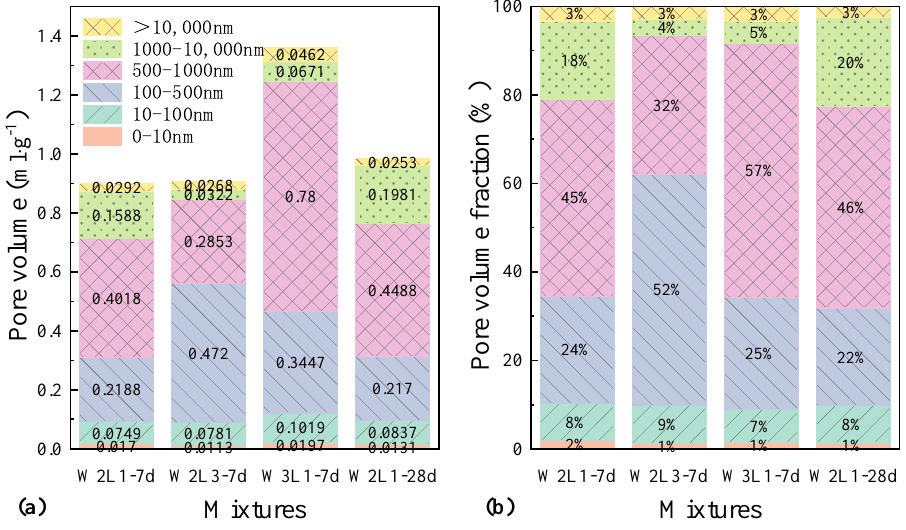
Figure 4. The distribution of pore volume with different